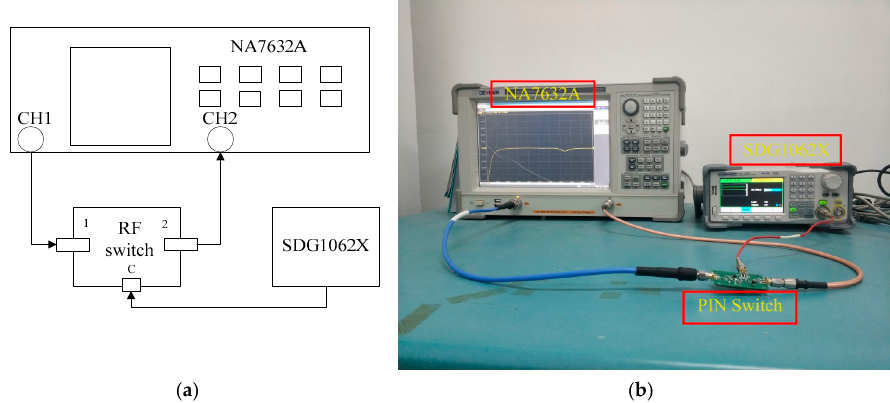
Figure 12. Experimental platform for testing the other technical metrics of RF switches: ( a ) Block diagram of the experimental platform and ( b ) Photograph of the experimental platform.